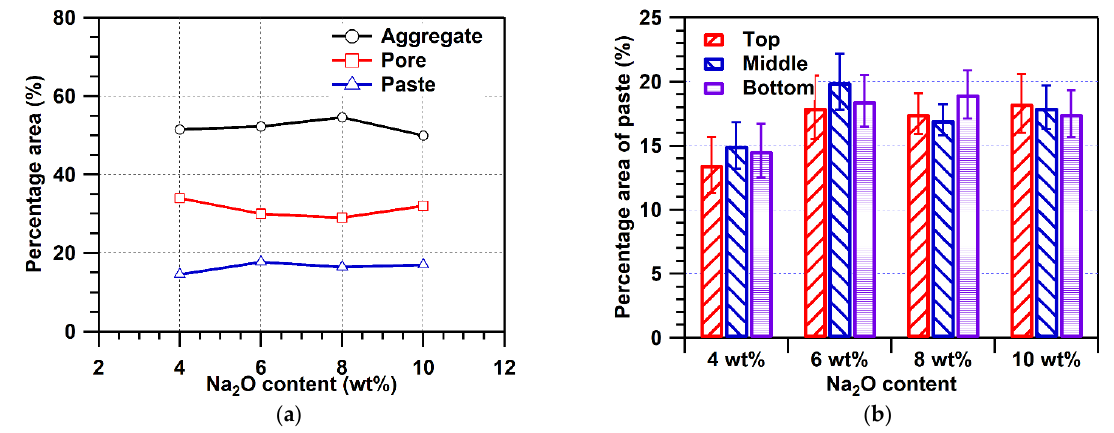
Figure 14. ( a ) Relationship between the water glass content and the percent area of aggregate, paste and pore on the vertically cut surface of pervious concrete; ( b ) percent area of paste on the top, middle and bottom parts of vertically cut surface of pervious concrete with different water glass content.